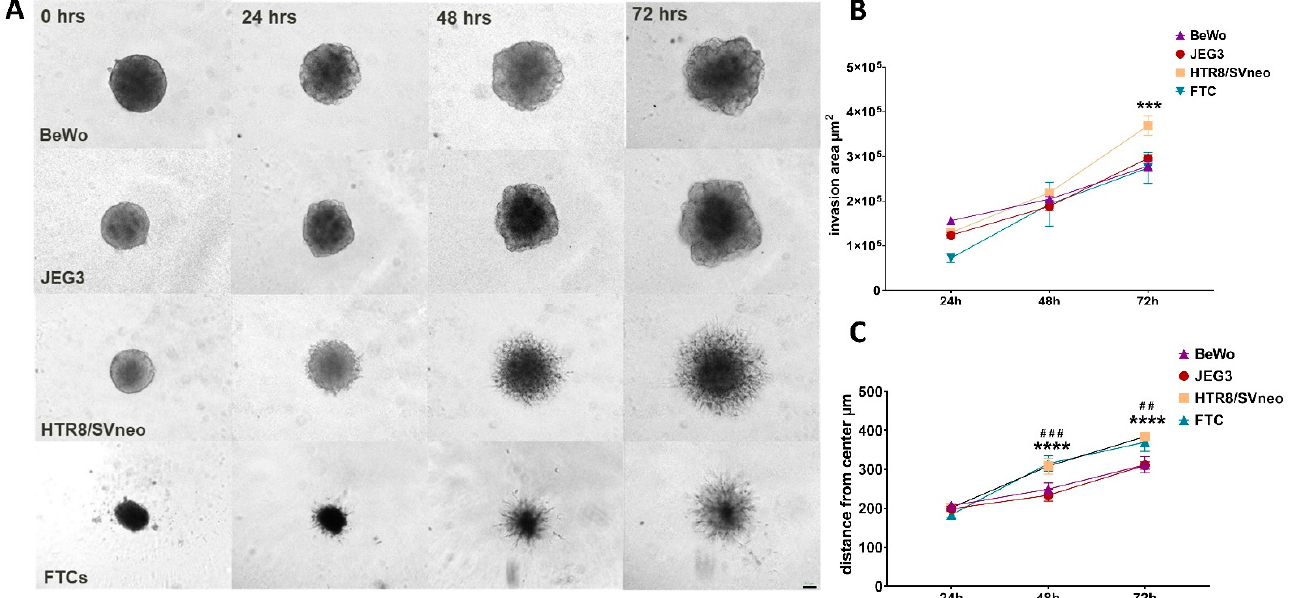
Figure 4. Invasive properties of trophoblast spheroids. Bright-field images of BeWo, JEG3, HTR8/SVneo and FTCs spheroids at 0, 24, 48 and 72 h; scale bare 100 µ m ( A ). Comparison of total invasion area in µ m 2 ( B ) and distance of invasion starting from the center in µ m ( C ). *** p < 0.001; **** p < 0.0001 versus HTR8/SVneo spheroids and ## p < 0.01; ### p < 0.001 versus FTCs spheroids within the same time point.